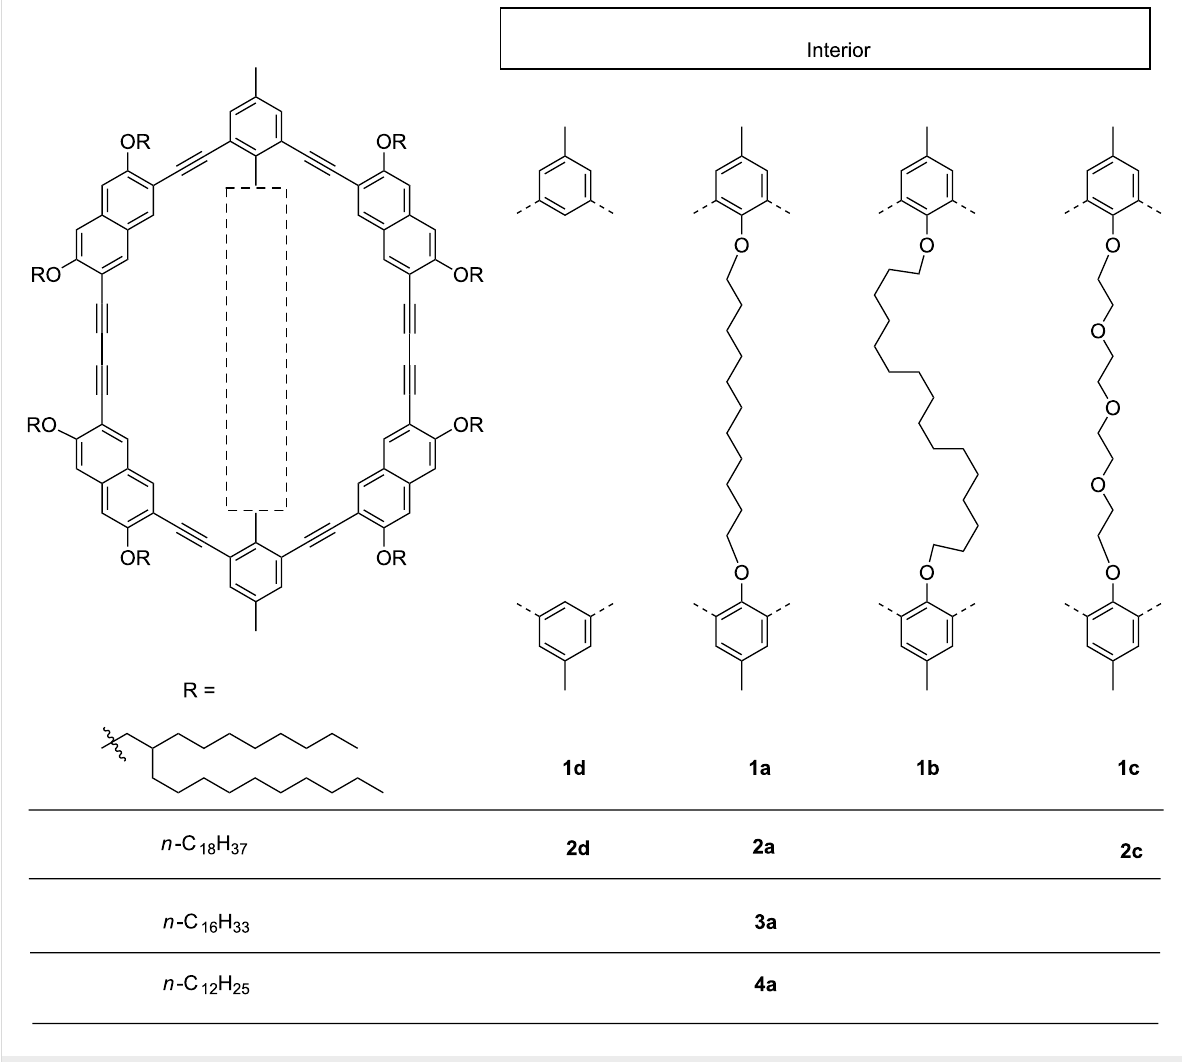
Figure 1: Shape-persistent macrocycles with different peripheral side groups and intraannular